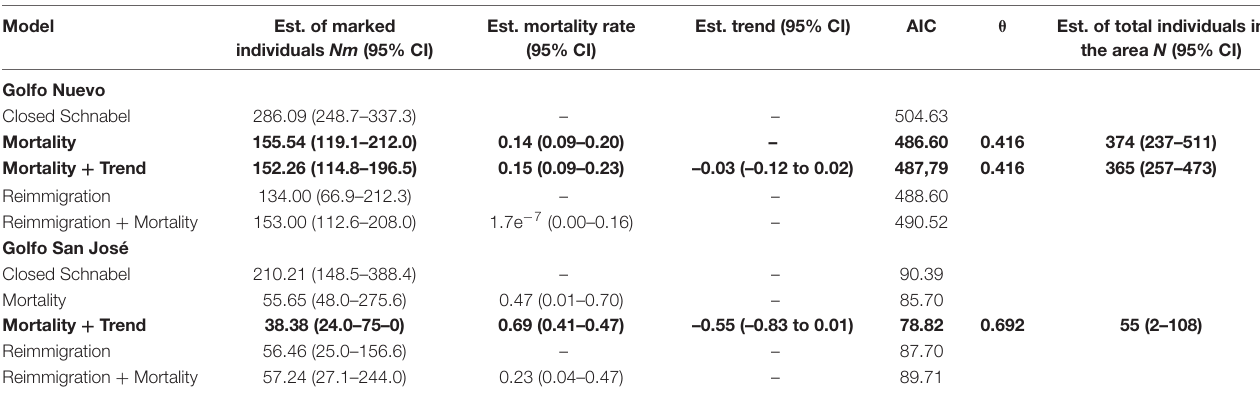
TABLE 2 | Inter-year population abundance model results for dusky dolphins observed in Golfo Nuevo and Golfo San José.